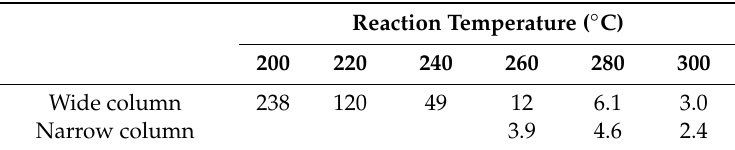
Table 1. Ethanol / acetic acid molar ratio in the reaction mixture of hydrogenation of aqueous acetic acid (10g / L).